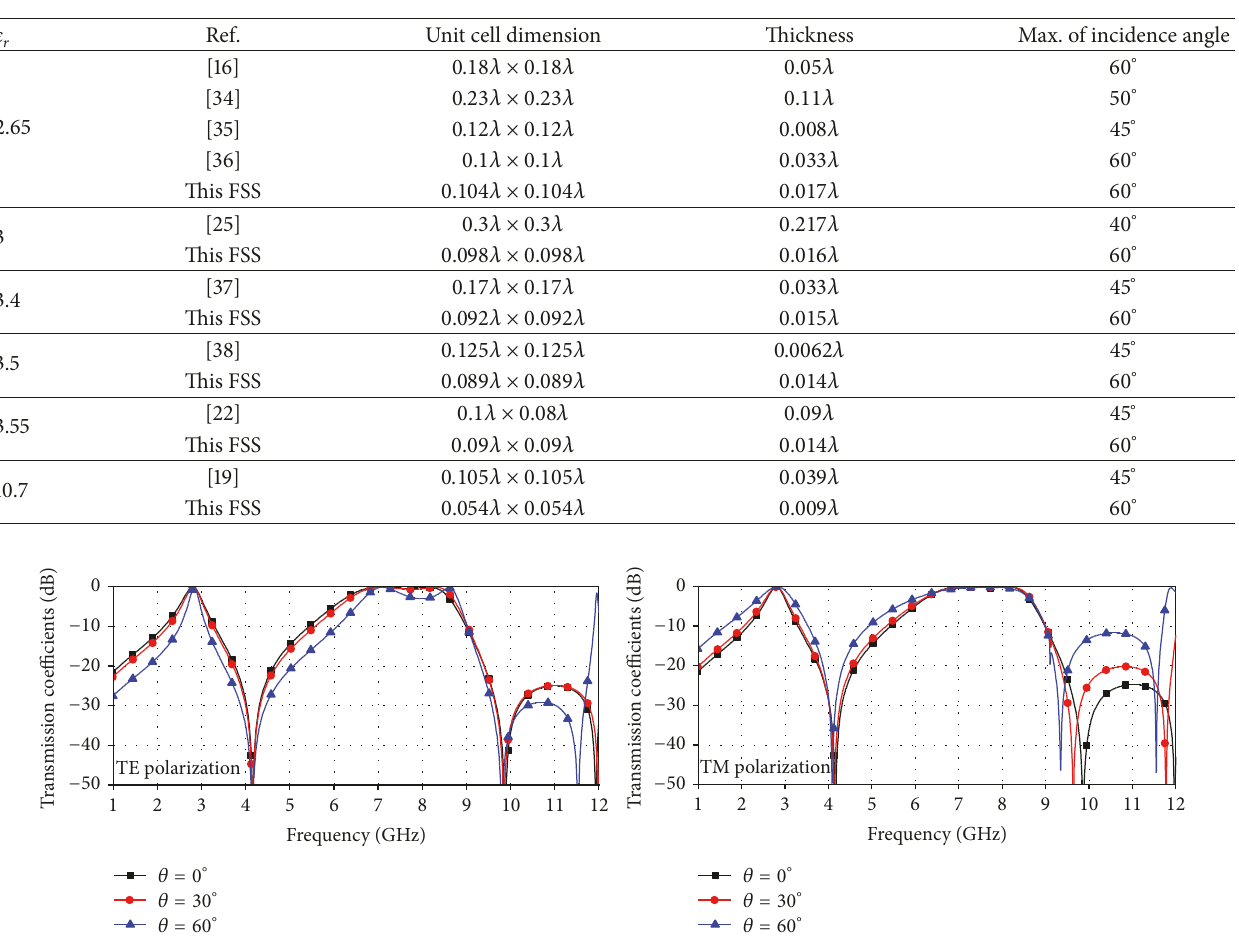
Figure 5: Transmission coefficients of the dual-band FSS under different incident angles.